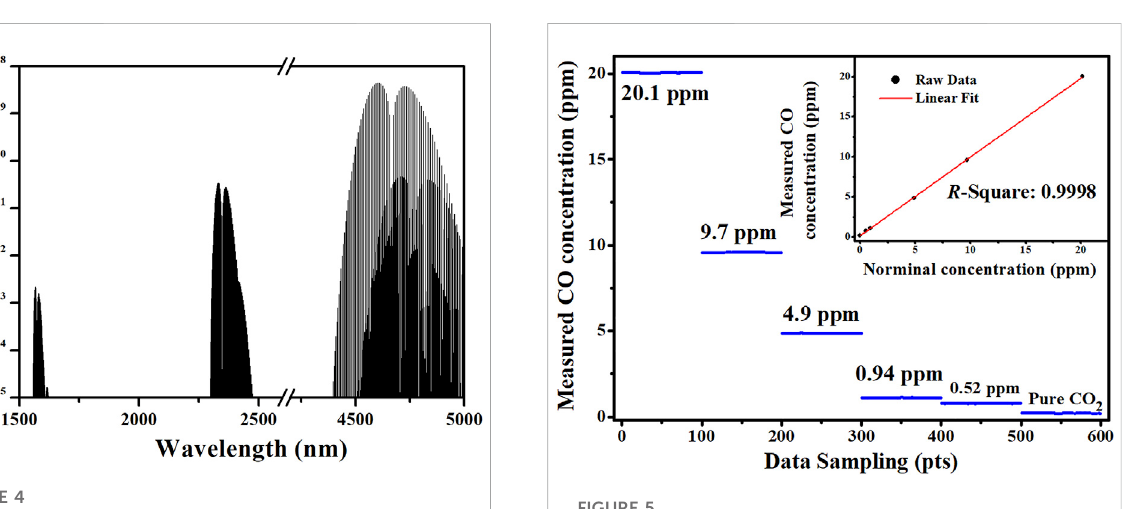
FIGURE 5 The typical measurement data of CO monitoring